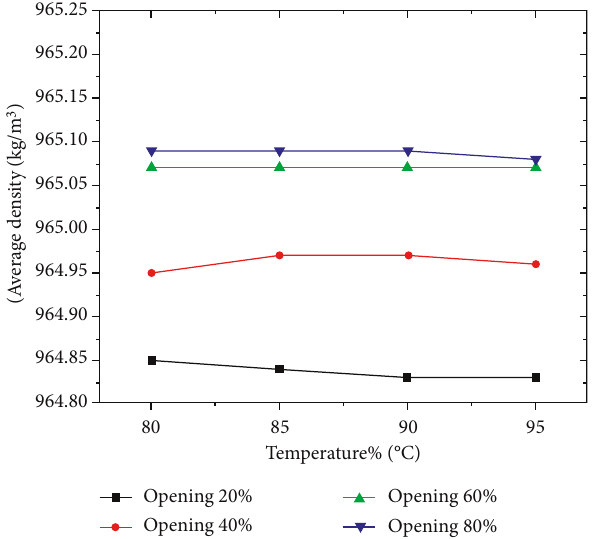
Figure 41: Variation of inlet velocity constant temperature and average density with openness.